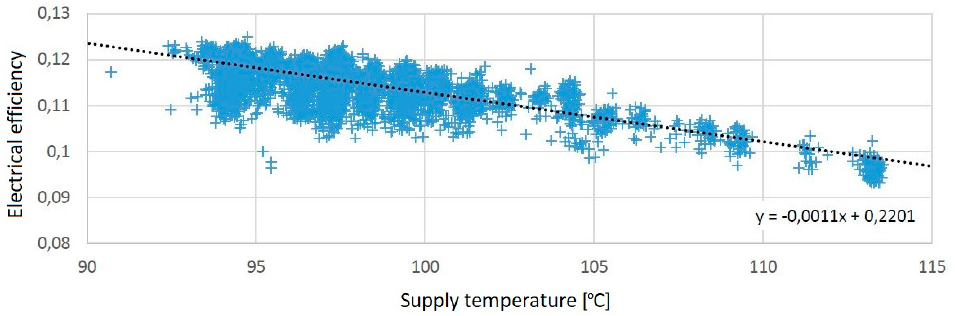
Figure 9. Measured efficiencies for KV50 turbine—waste incineration plant. Energies 2019 , 12 , x FOR PEER REVIEW